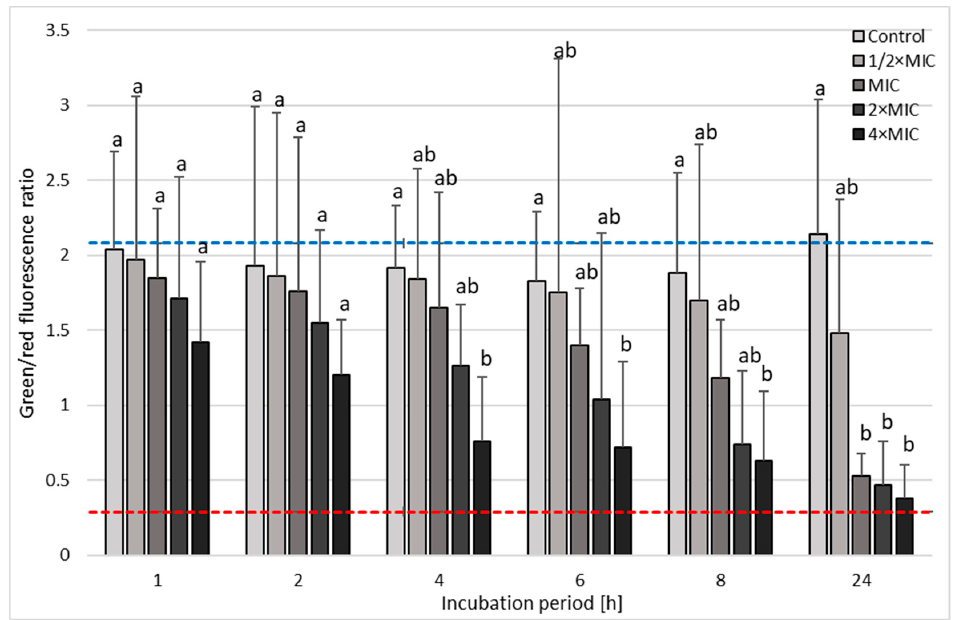
Figure 7. The fluorescence microscopy analysis of the viability during the incubation of H. pylori J99 with 3-Bromopyruvate (3-BP) in time. The blue top and red bottom lines indicate the positive (0 h incubation) and negative controls (1 h treatment with 70% ethanol), respectively. Columns with the same subscript letters are not significantly different from each other ( p > 0.05).